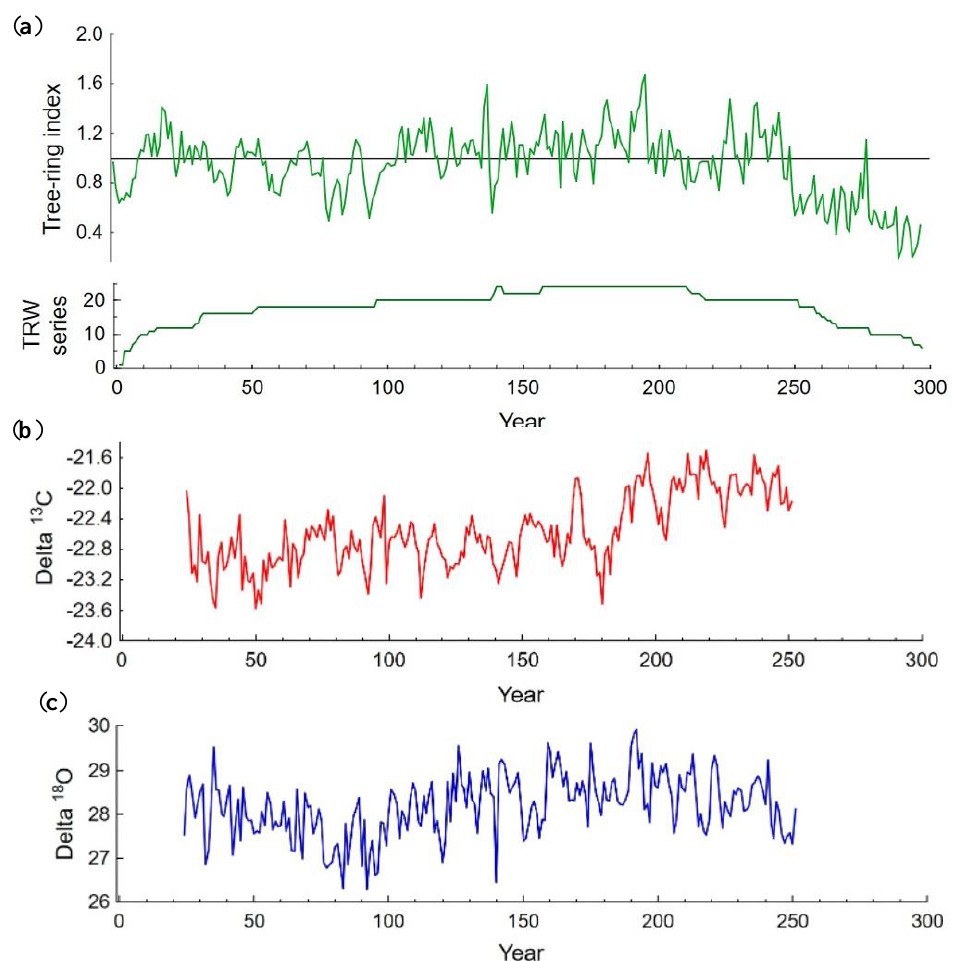
Figure 2. Tree-ring chronologies developed from width ( a ), δ 13 C ( b ), and δ 18 O ( c ) of the tree rings of Douglas fir found in the ancient landslide. The panel below the ring width chronology ( a ) indicates the number of tree-ring series included into the chronology.